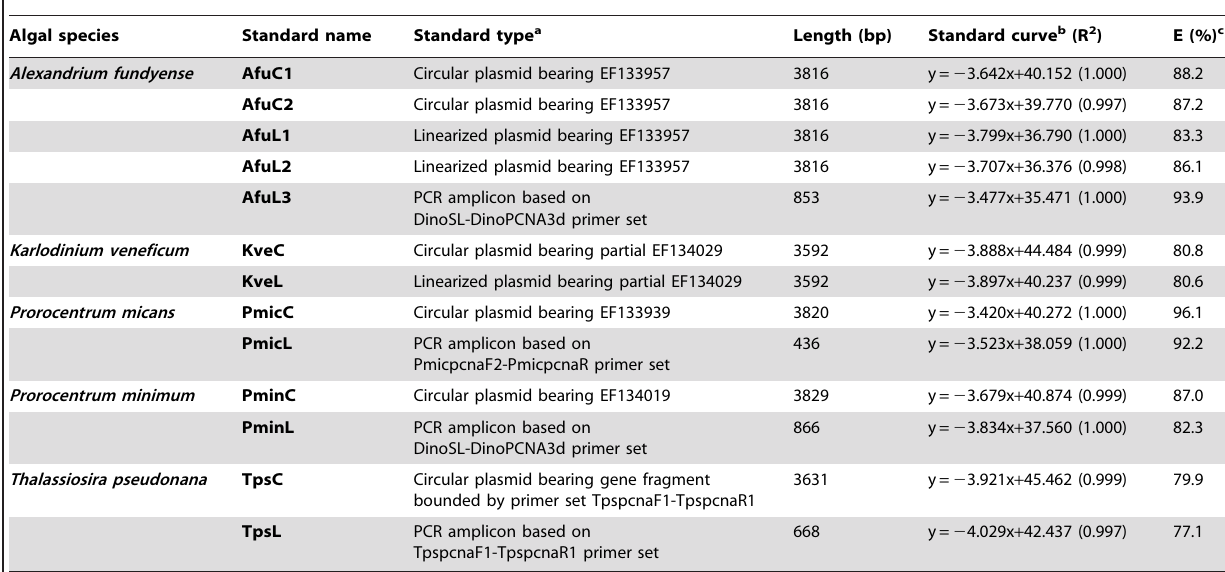
Table 2. Types and performance of standard DNA in qPCR in various algal species